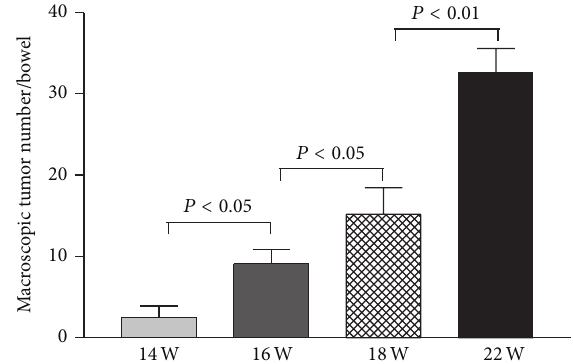
Figure 1: Increased tumor number in the bowels over examined time-points. The data showed that the overall tumor number in the bowels after the administration of DMH and DSS was gradually increased after induction for 14 weeks and through 22 weeks.